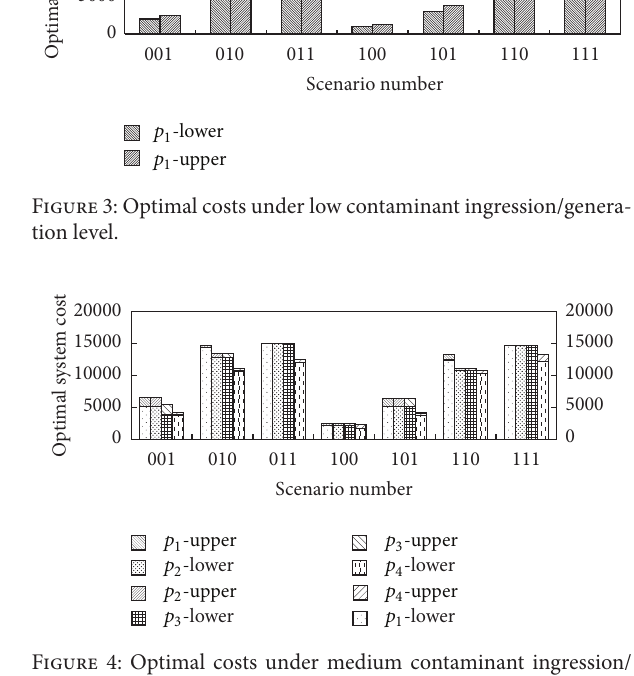
Figure 4: Optimal costs under medium contaminant ingression/ generation